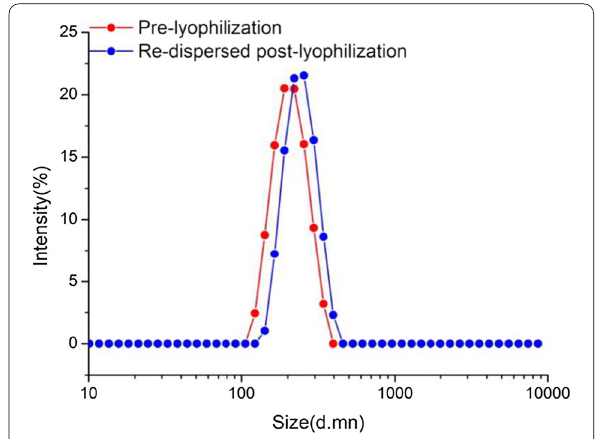
Fig. 3 Stability of ICA-loaded mPEG-ICA NPs